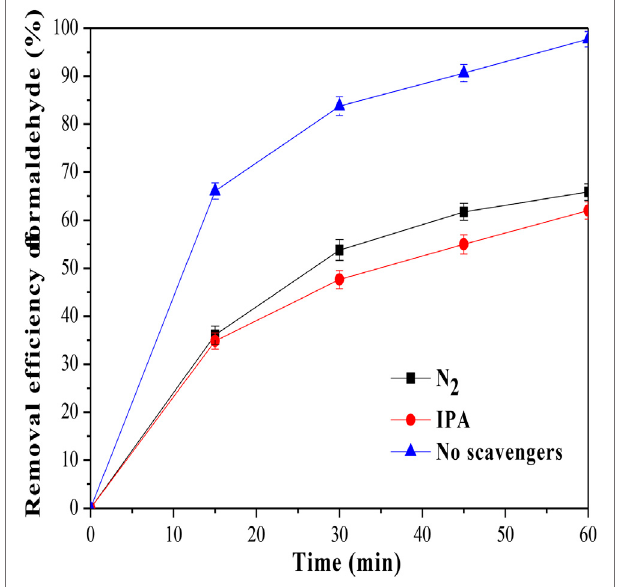
FIGURE 6 | Effect of scavengers on the formaldehyde removal in the photocatalytic system.